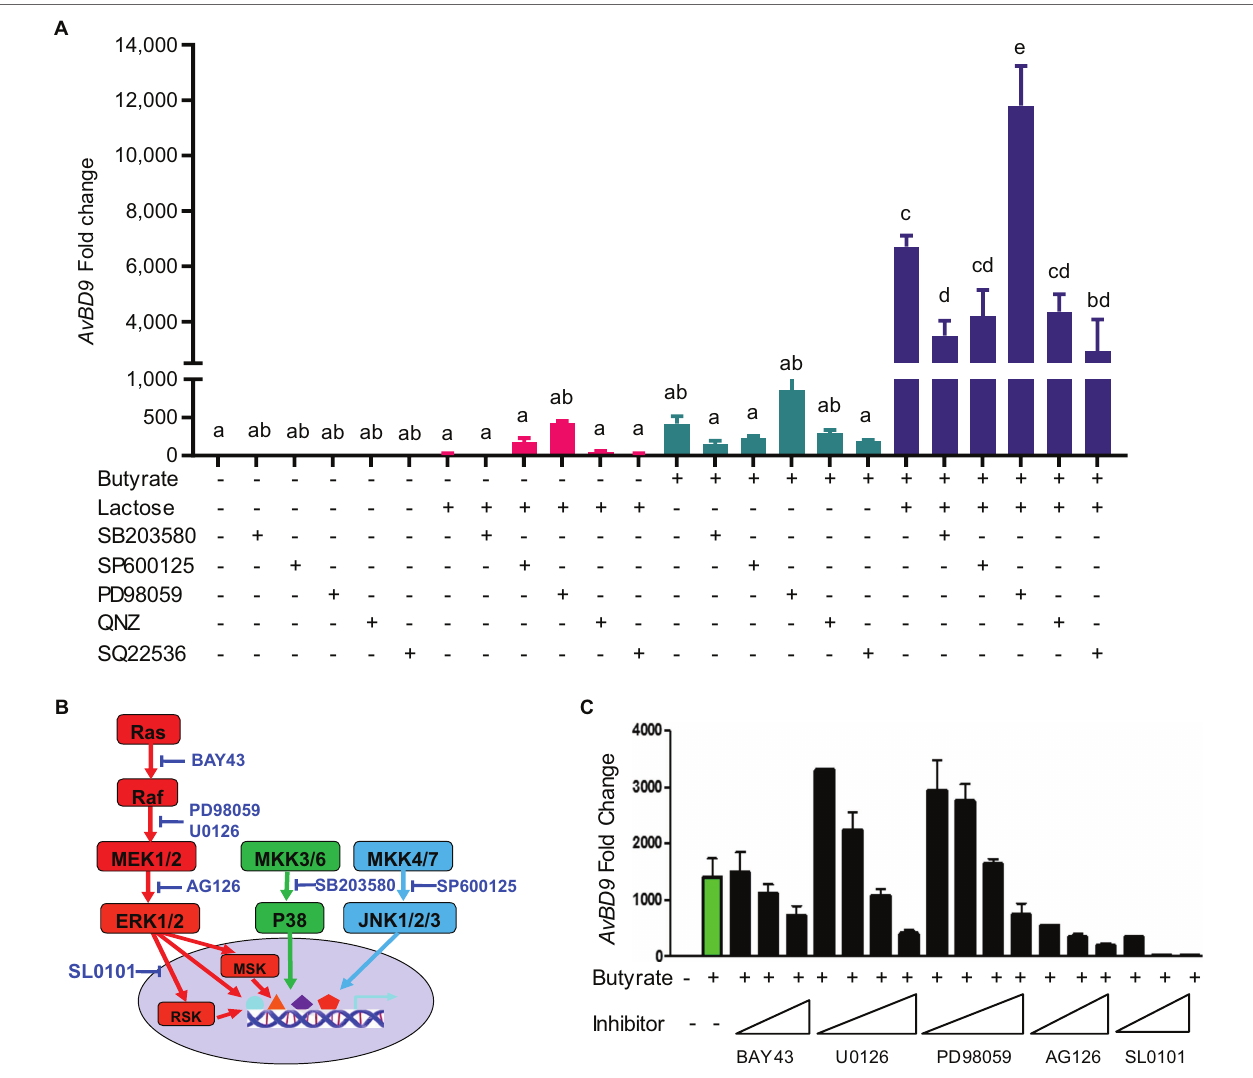
FIGURE 10 | Involvement of mitogen-activated protein kinase (MAPK), NF- κ B, and cAMP signaling pathways in AvBD9 induction mediated by butyrate and lactose. (A) Chicken HD11 cells were pretreated for 1 h with or without a specific inhibitor for p38 MAPK (SB203580), JNK (SP600125), MEK1/2 (PD98059), NF- κ B (QNZ), or cAMP signaling (SQ22536), followed by stimulation with 2 mM sodium butyrate and 0.2 M lactose separately or in combination for another 24 h. (B) A schematic drawing of three canonical MAPK pathways showing the steps where specific inhibitors act. (C) HD11 cells were pretreated for 1 h with or without an indicated inhibitor for the Ras-Raf-MEK-ERK-RSK pathway, followed by stimulation with 2 mM sodium butyrate for another 24 h. RT-qPCR analysis of AvBD9 expression was performed. Results are shown as means ± SEM of 2–3 independent experiments. The bars without common superscript letters denote statistical significance ( p < 0.05) as determined by one-way ANOVA and post hoc Tukey’s